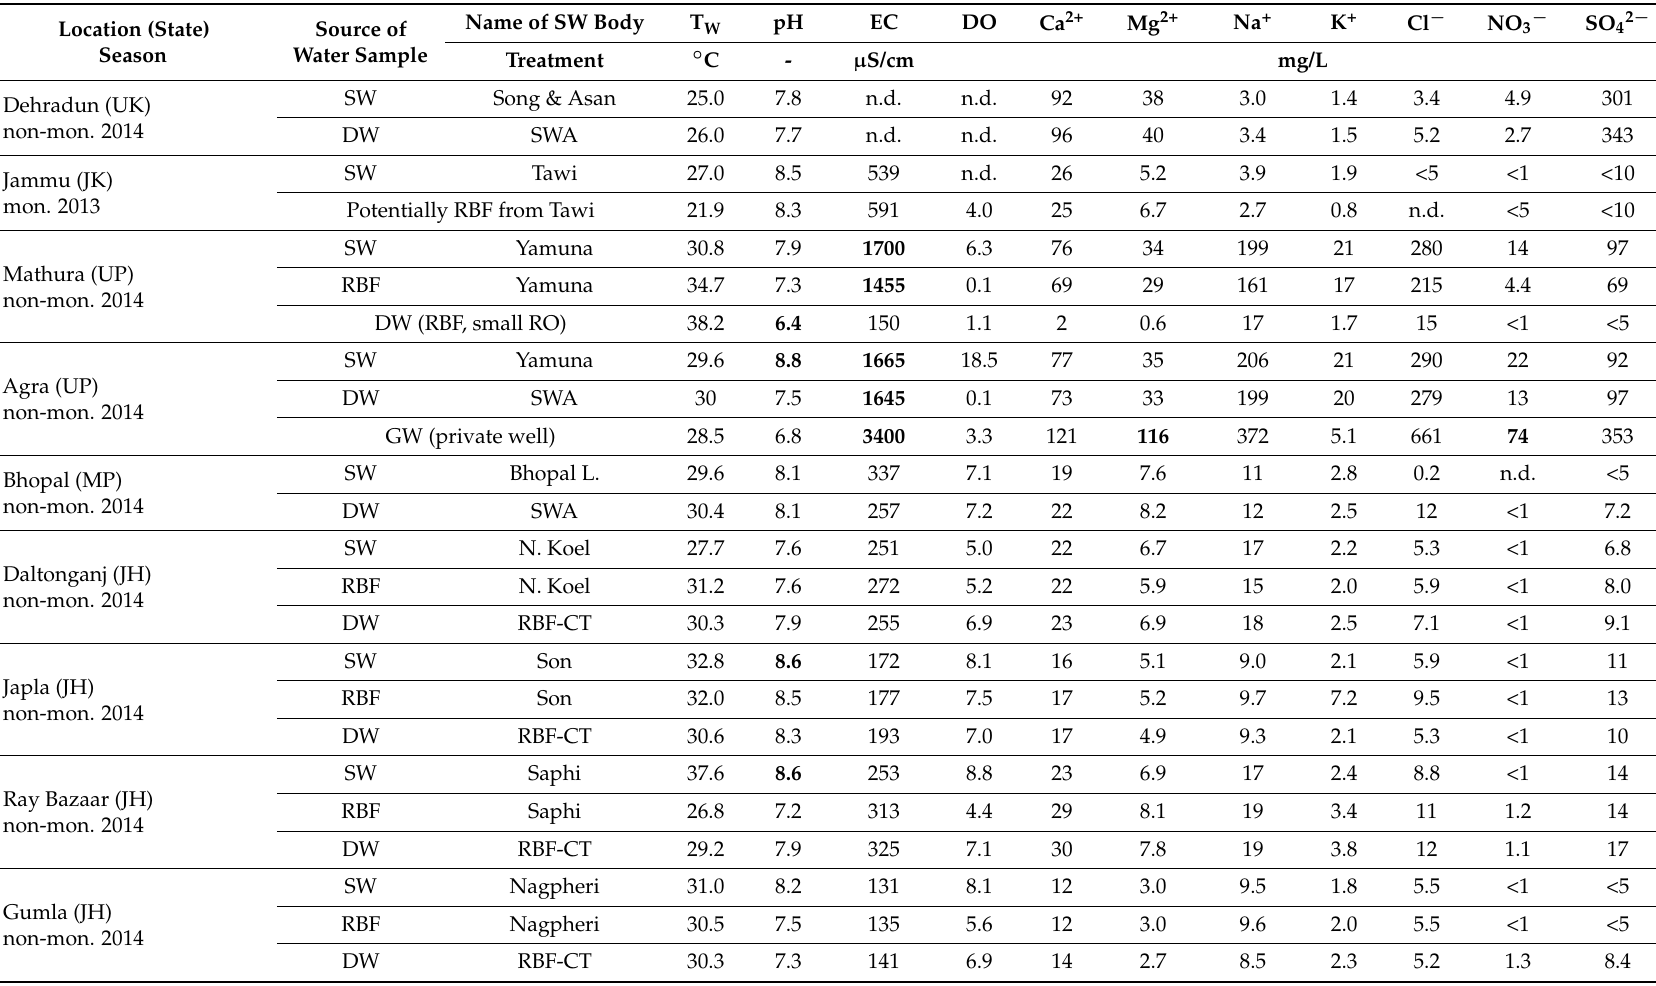
Table 1. Field parameters and major ions of source water, RBF well water, and drinking water at various locations sampled in 2013 and 2014 ( n = 1 for each source at each